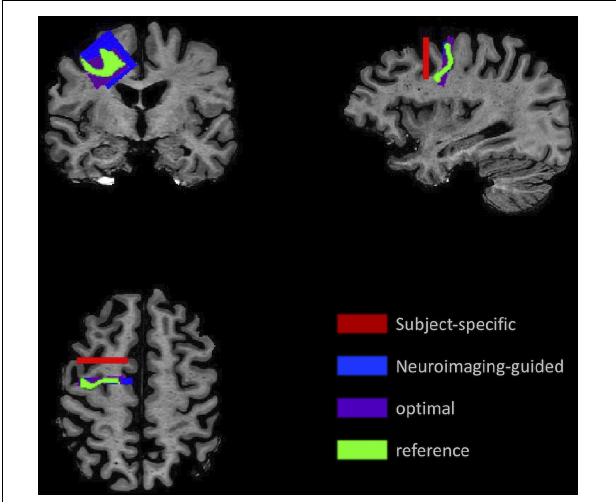
FIGURE 3 | Illustration of the sampling framework supporting assessment of precision and accuracy. Position of the samples demonstrates the variation in location and angle of the MFG ROI for the subject-specific samples (red) generated using traditional neuropathologic sampling and the reference sample (light green) which indicated the intended target. Using the reference sample to guide slice sampling results in the neuroimaging-guided sample (blue), which shows marked improvement in overlap with the reference sample. The highest overlap that could be achieved with slicing at any angle or coronal position is the optimal sample